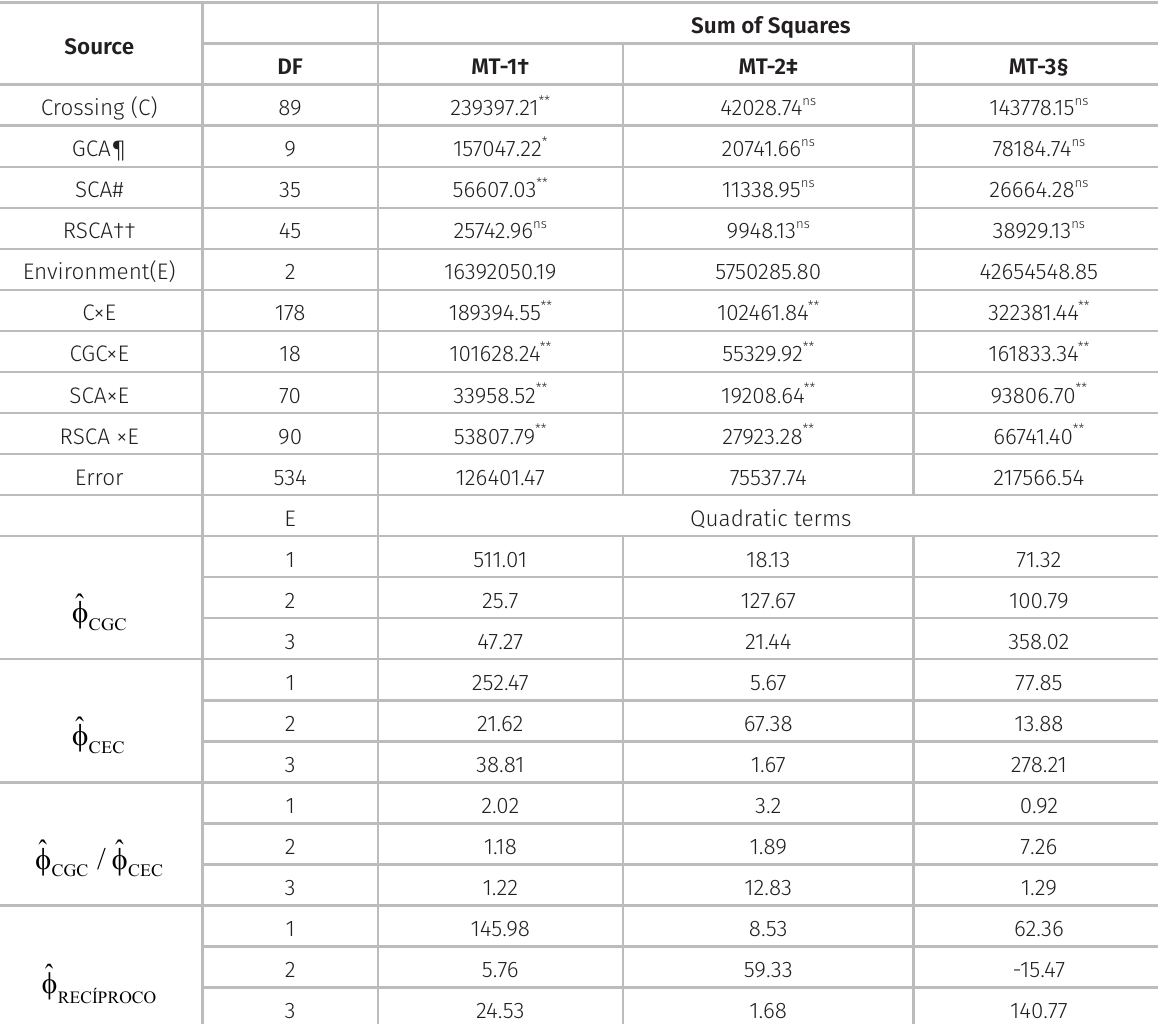
Table II. Multivariate diallel analysis of variance for the three mega-traits assessed in 90 simple hybrids grown in three